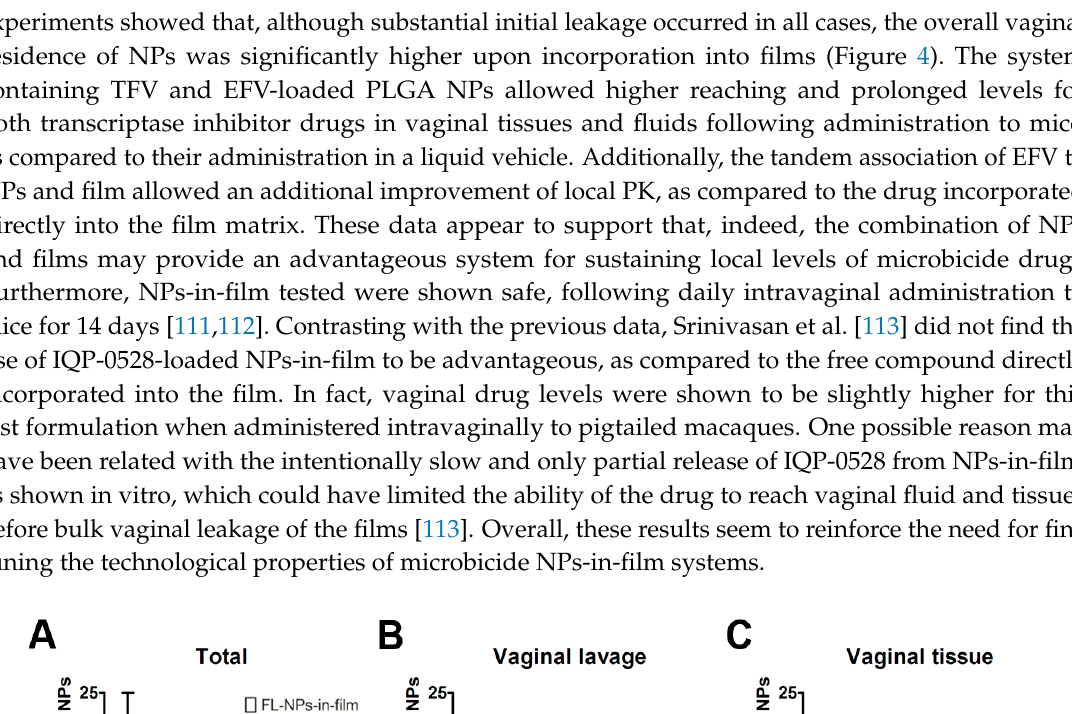
Figure 4. Distribution of fluorescent NPs (FL-NPs) at different times after intravaginal delivery in phosphate buffered saline (FL-NPs in PBS) or film (FL-NPs-in-film). Results are expressed as the ( A ) total amount of recovered particles or fractions retrieved from ( B ) vaginal lavage and ( C ) vaginal tissues. Columns and bars stand for mean and standard error of the mean values, respectively, and (*) indicates p < 0.05 (Student’s t -test; n = 3). Adapted from [111], Copyright (2016), with permission from Elsevier.